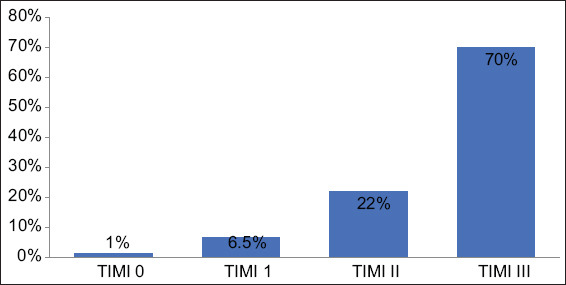
Coronary flow profile following primary percutaneous coronary intervention.